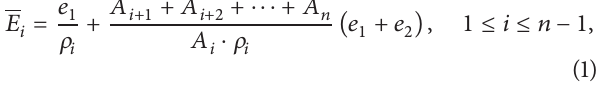
algorithm to solve the energy hole problem in a